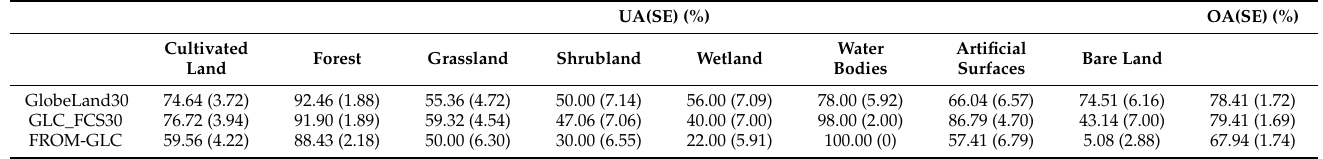
Table 4. UAs and OAs of base products for 2020.